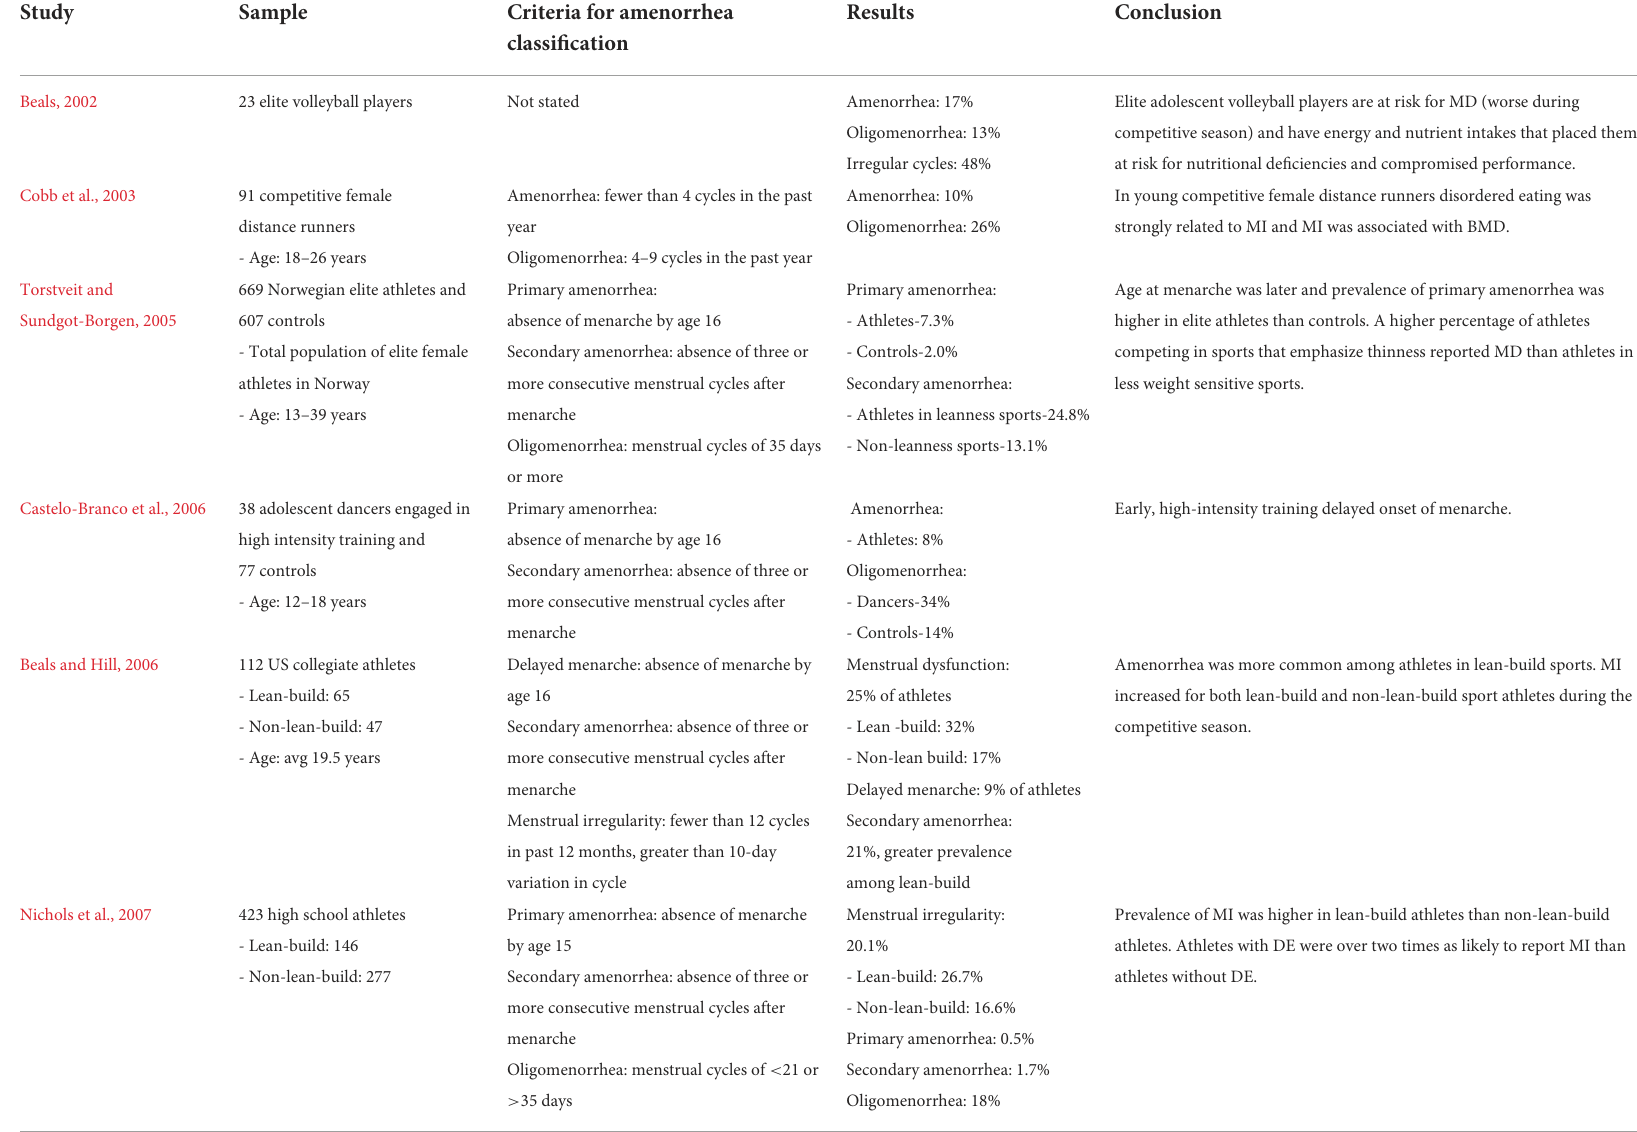
TABLE 1 Prior research examining menstrual dysfunction in